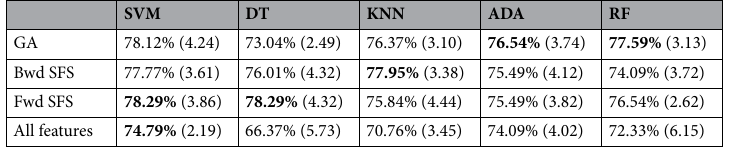
Table 4. Best accuracy for each ML model—without expert’s opinion as input. STD is included in parentheses. Significant values are in